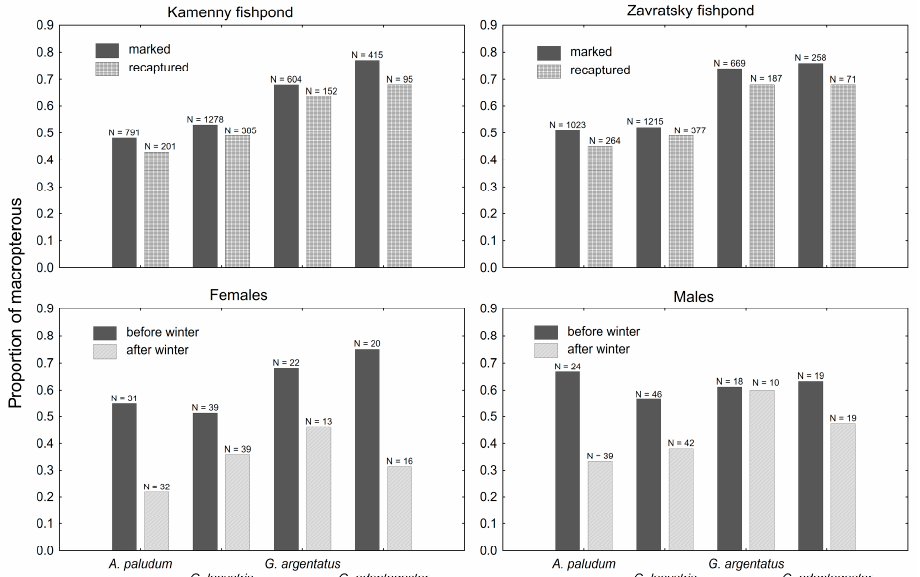
Figure 5. A comparison of the proportion of macropterous adults in marked and recaptured individuals at both sites (upper panels) and in both sexes before and after winter (bottom panels). The proportion of macropterous was lower in recaptured bugs (upper panels), and after the winter (bottom panels). Table 4. Summary of marked individuals and catches at Bily Kamen fishponds system (B) and Motovidlo fishponds system (M). Data pooled from all